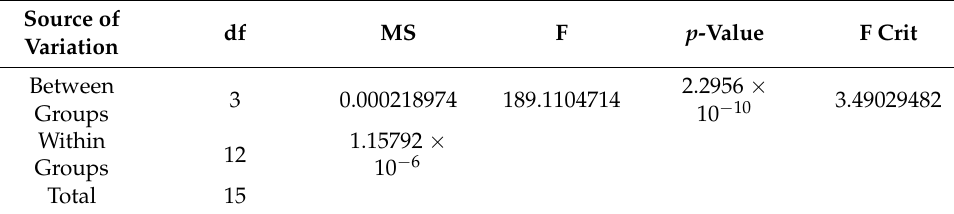
Table 3. The post-hoc Tukey HSD analysis of four group